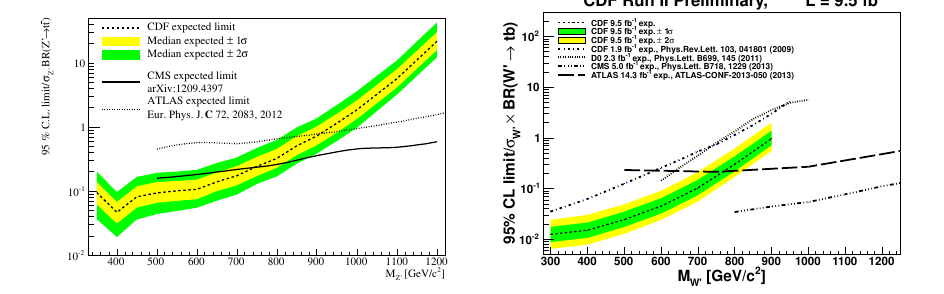
Figure 2. Limits on exotic weak boson production from